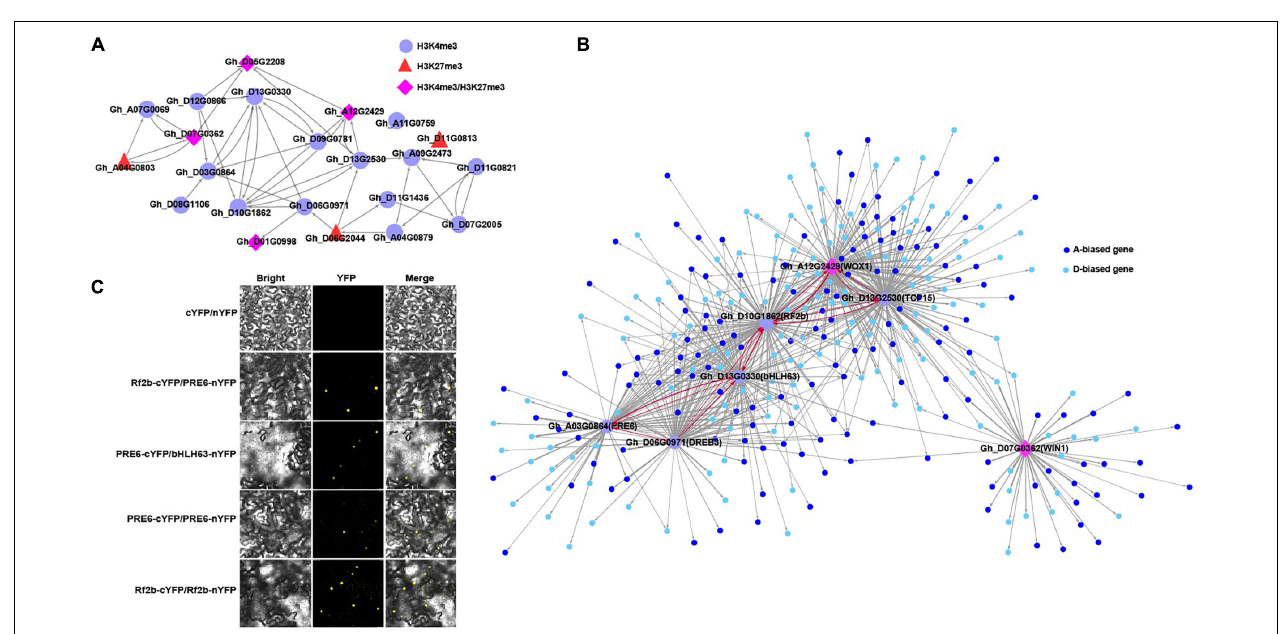
FIGURE 4 | Regulatory network in cotton leaf tissue. (A) Overview of predicted regulatory network containing 22 hub TFs with different marks in the blue module. The TFs with H3K4me3, H3K27me3, and H3K4me3/H3K27me3 marks were indicated using different shapes and colors; the arrow represents the direction of regulation. (B) The directional regulatory network show the top 7 TFs with the most edges in (A) and their predicted regulated genes (small nodes with different colors), the arrow represents the direction of regulation, the red line indicates interactions between TFs, thickness of the line represents the weight value. (C) BiFC analyses of protein–protein interactions of PRE6, Rf2b and bHLH63. Bright, YFP, and Merge (bright-field and yellow fluorescent), Rf2b-cYFP/PRE6-nYFP: the C-terminal half of YFP was fused to the C-terminal of PRE6, Rf2b and bHLH63 to generate PRE6-cYFP, Rf2b-cYFP, and Bhlh63-cYFP, whereas the N-terminal half of YFP was fused to the N-terminal of PRE6, Rf2b, and bHLH63 to generate PRE6-nYFP, Rf2b-cYFP, and bHLH63-cYFP; Agrobacterium combination of Rf2b-cYFP/PRE6-nYFP, PRE6-cYFP/bHLH63-nYFP, PRE6-cYFP/PRE6-nYFP, and Rf2b-cYFP/Rf2b-nYFP were individually co-injected into N. benthamiana leaves for transient expression. The fluorescent signal was monitored and recorded by confocal microscopy at 72 h post-infiltration. Bar: 25 µ m.